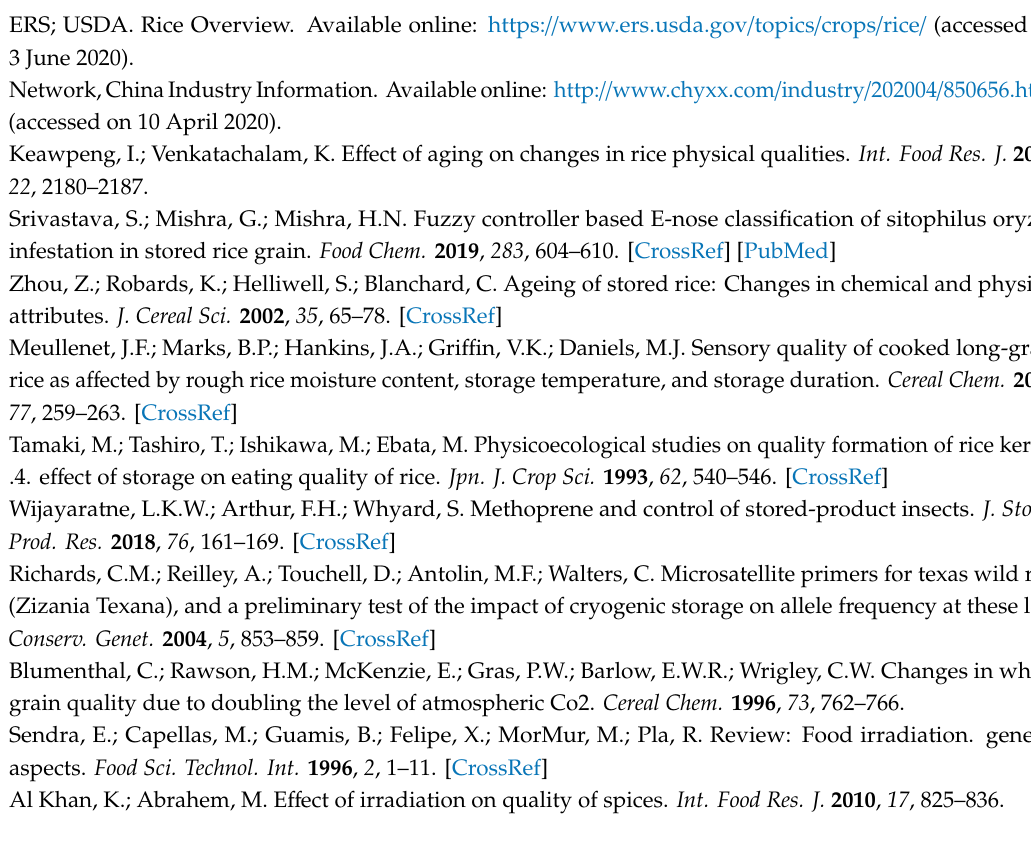
Table S1: Di ff erences in proton areas and peak times among rice samples with di ff erent moisture contents, Table S2: Pasting properties of LM and HM rice samples under various irradiation doses, Table S3: Thermal properties of flours prepared from rice grains treated with various irradiated